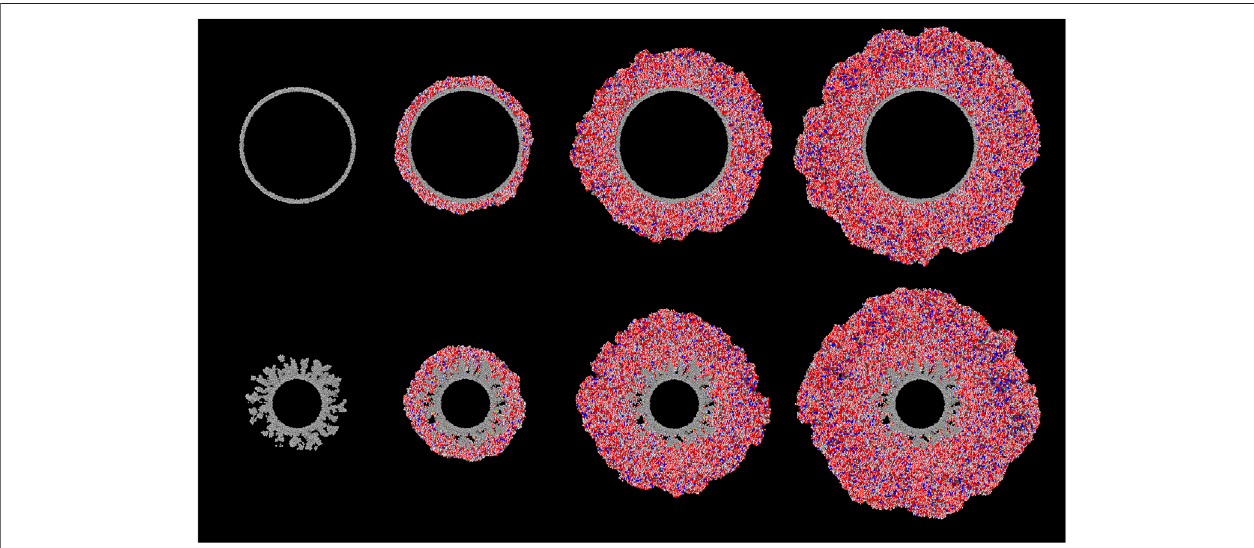
FIGURE2| Ray-traced, cross-sectionalimagesofthelarge (100 Åradius) non-porous (top) and large porous (bottom) graintypes atdifferentstagesoficebuild- up; left to right: interval 0, interval 100, interval 500, interval 1,000. Gray spheres represent the carbon atoms composing the dust grain. Grain-surface atoms are represented by spheres of white (H), red (O), black (C) and blue (N). Molecules are similarly represented as collections of such atoms in appropriate structures. H 2 molecules are colored yellow for ease of identi fi cation.